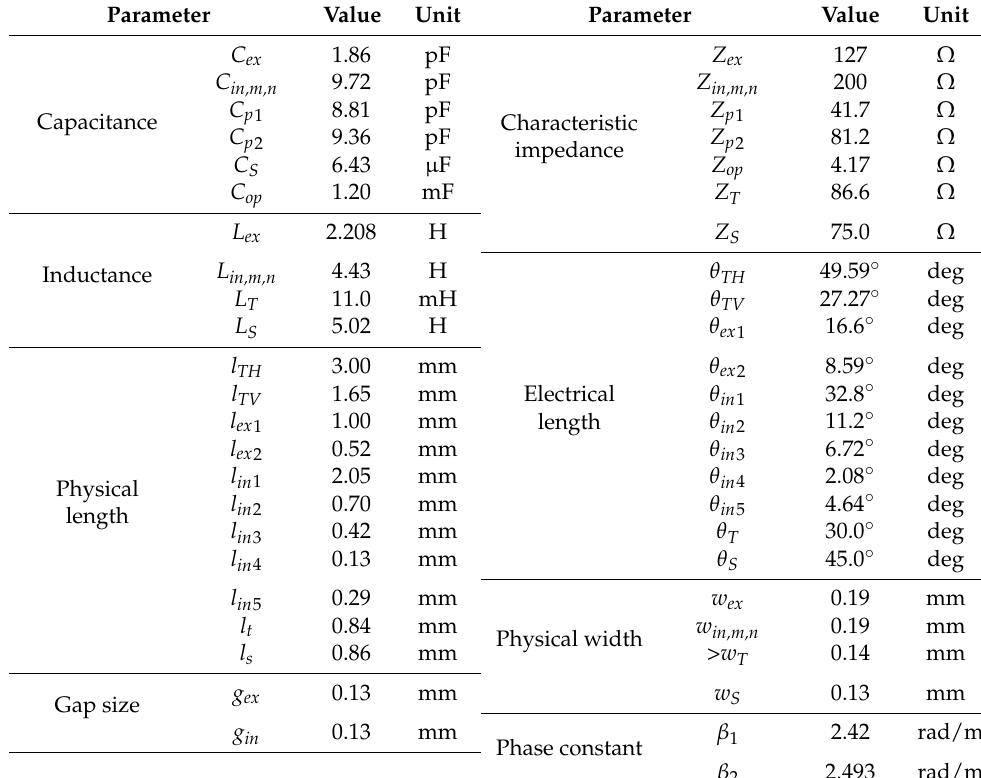
Table 2. Parameters of the proposed